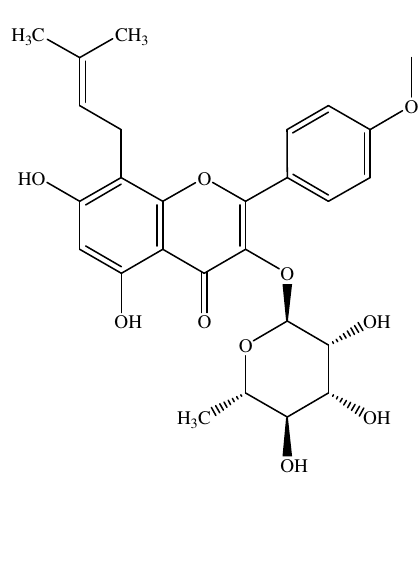
Figure 1. Structure of icariside